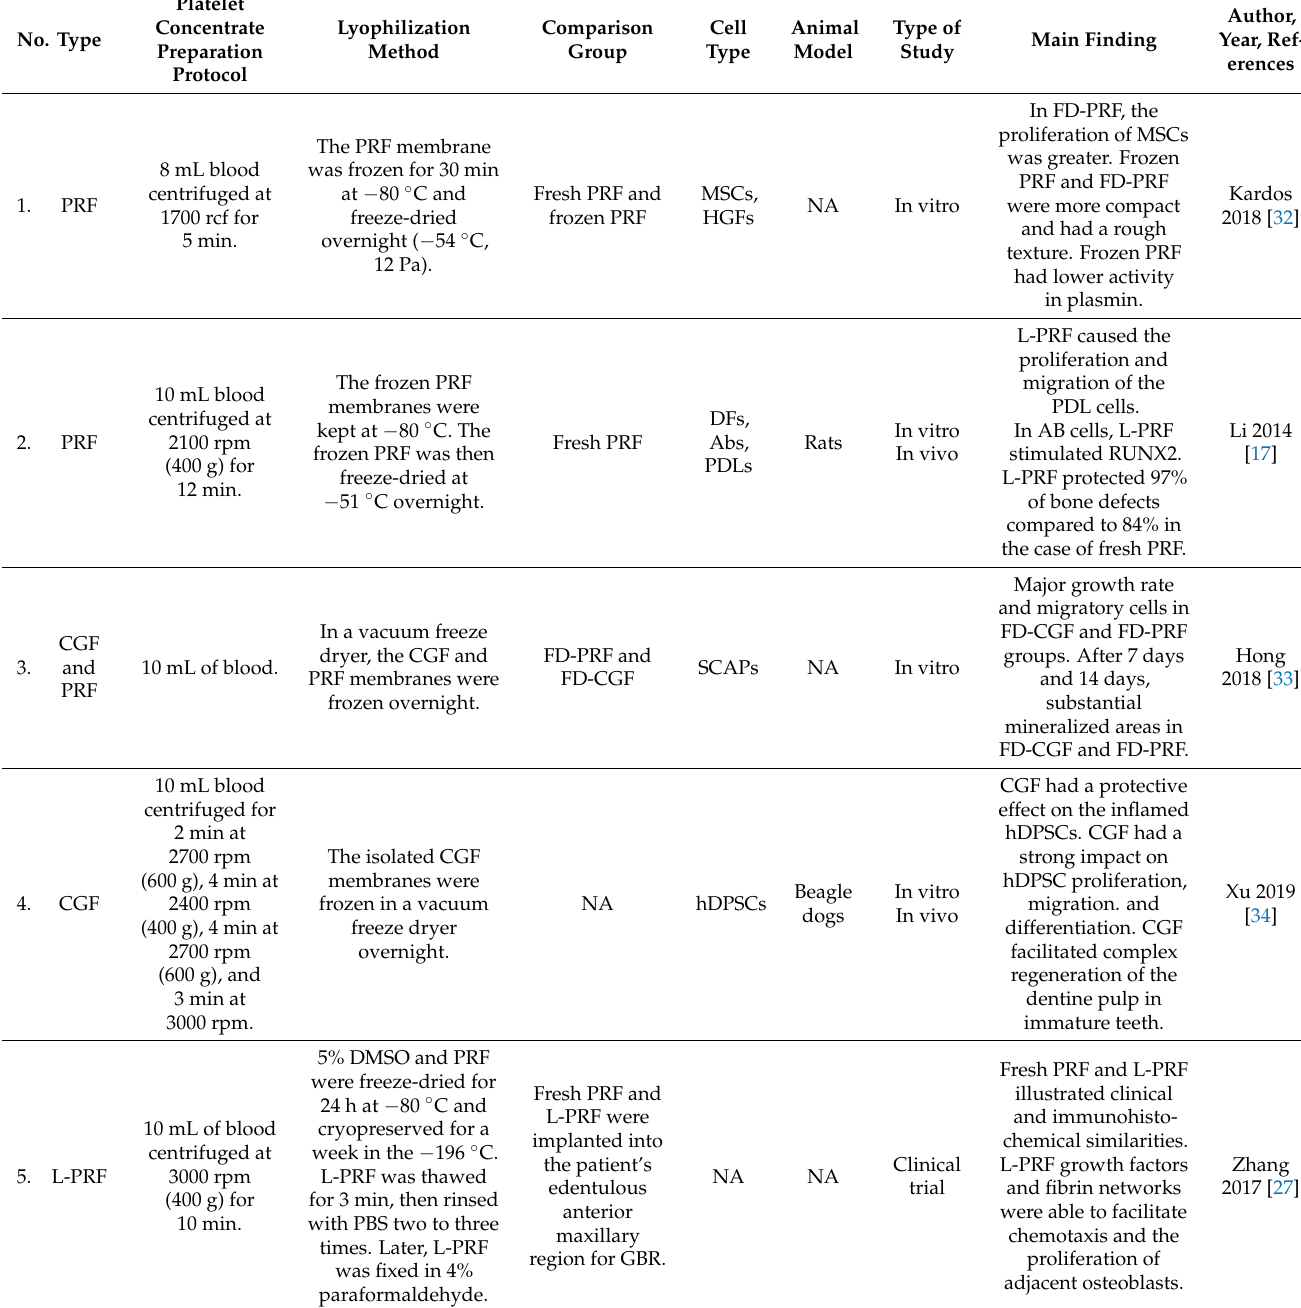
Table 2. Summary findings of in-vitro, in-vivo and clinical trial studies using lyophilized platelet concentrates (LPCs).